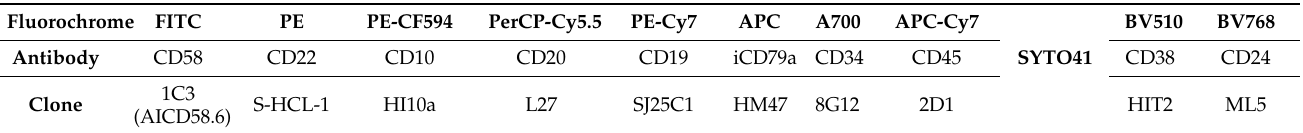
Table 1. Eleven-color antibody panel for MFC-MRD in BCP-ALL patients after CD19-directed therapy with information about clones, fluorochromes and